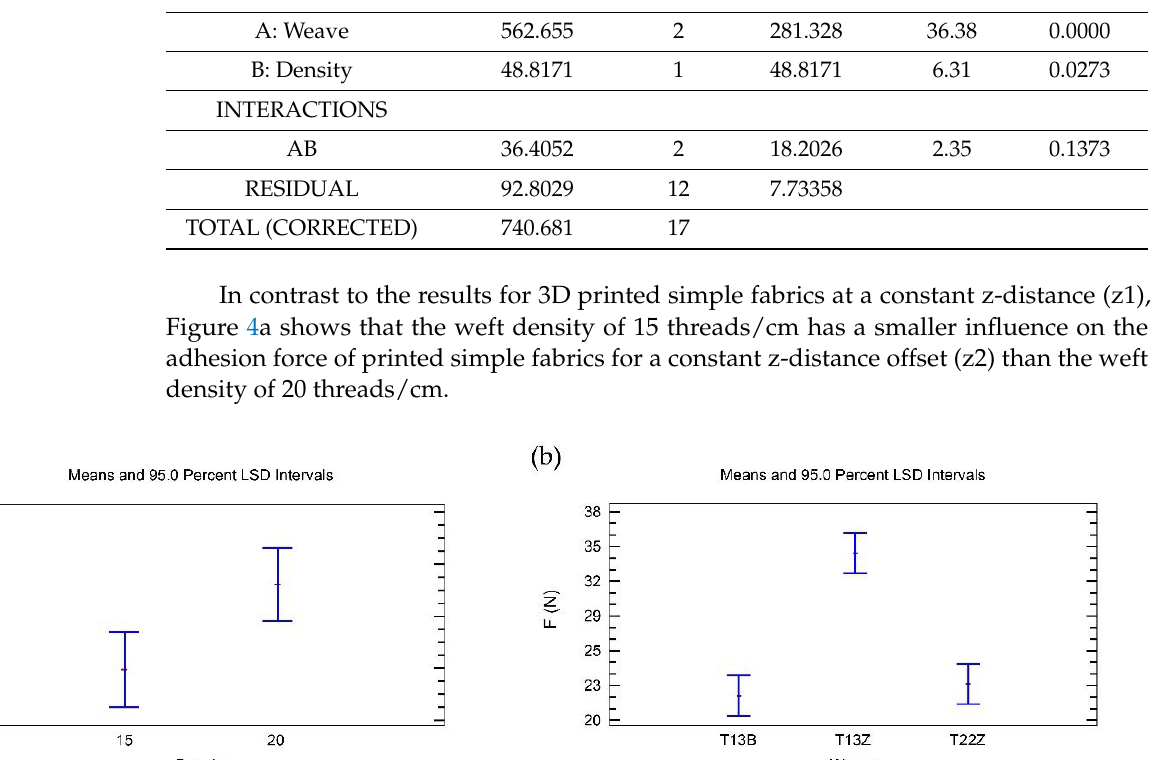
Table 7. Impact of weave and density on the adhesion force for simple fabrics for z2.